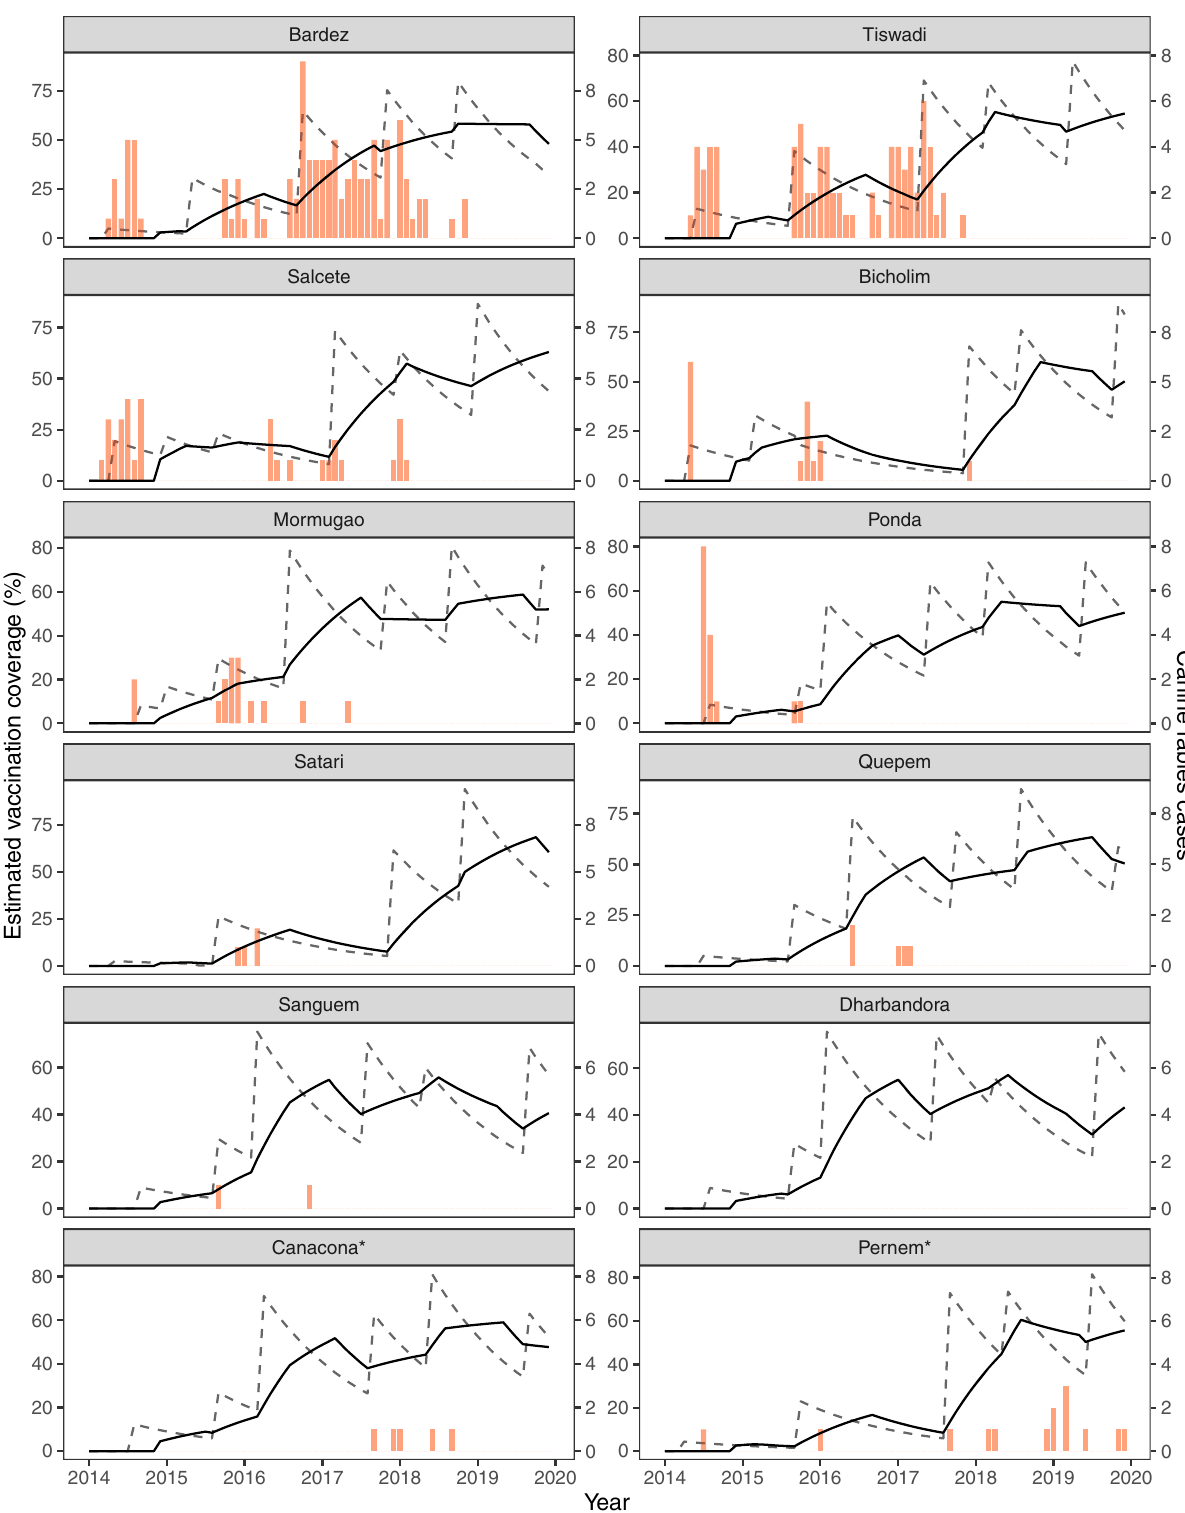
Fig. 3 Graph of month-wise estimated vaccination coverage (dotted line), rolling mean 12-month vaccination coverage (solid line), and monthly animal rabies cases (red bars) from 2014 to 2019 for each taluka region of Goa. Asterisk denotes talukas that immediately border areas of high dog density in other states in which rabies remains endemic. Month-wise estimated vaccination coverage was calculated from the number of vaccinations delivered by campaign cycle and total estimated dog population by region, with a month-wise estimate of population